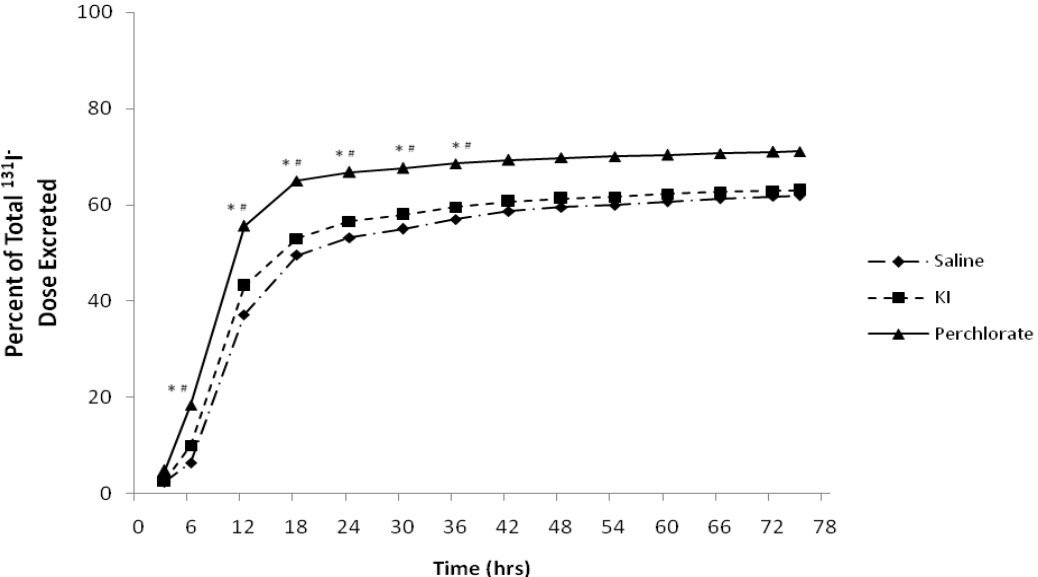
Figure 1. ( a ) Percent of total 131 I − dose excreted in urine 75 hour of Group 1 male rats collected via metabolism cages dosed with 131 I − followed by saline, KI (30 mg/kg), or perchlorate (30 mg/kg) 3 hours later (n = 12), statistical analysis was conducted on concentration data for each individual time-point (data not shown); ( b ) Percent of total 131 I − dose excreted in 75 hour urine of Group 2 male rats collected via metabolism cages dosed with 131 I − followed by saline, KI (30 mg/kg), or perchlorate (30 mg/kg) at +3 hours and dosed with replacement T at +3, +27, and +51 hours (n = 6), statistical analysis was 4 conducted on concentration data for each individual time-point (data not